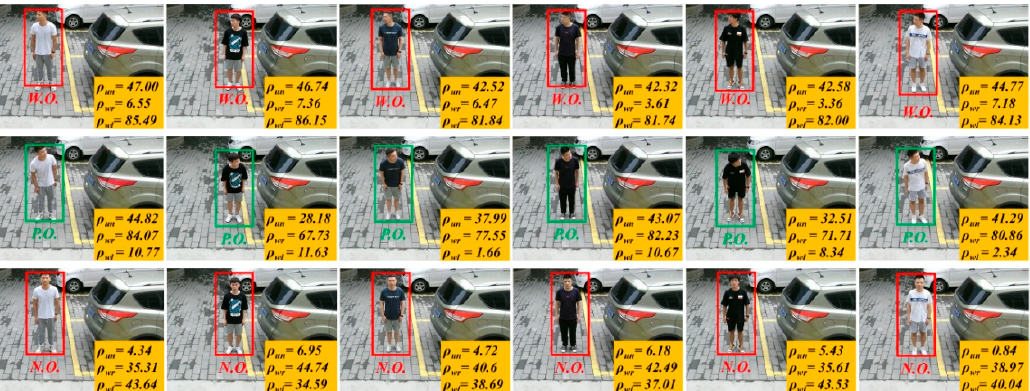
Figure 12. Schematic diagram of pedestrian blind spot observation status classification. N.O. denotes “No Observation”, meaning the pedestrian did not observe the traffic condition in the blind zone. P.O. denotes “Proper Observation”, meaning the pedestrian observed the traffic condition in the blind zone, and W.O. denotes “Wrong Observation”, meaning the pedestrian’s observation direction was opposite to the position of the blind